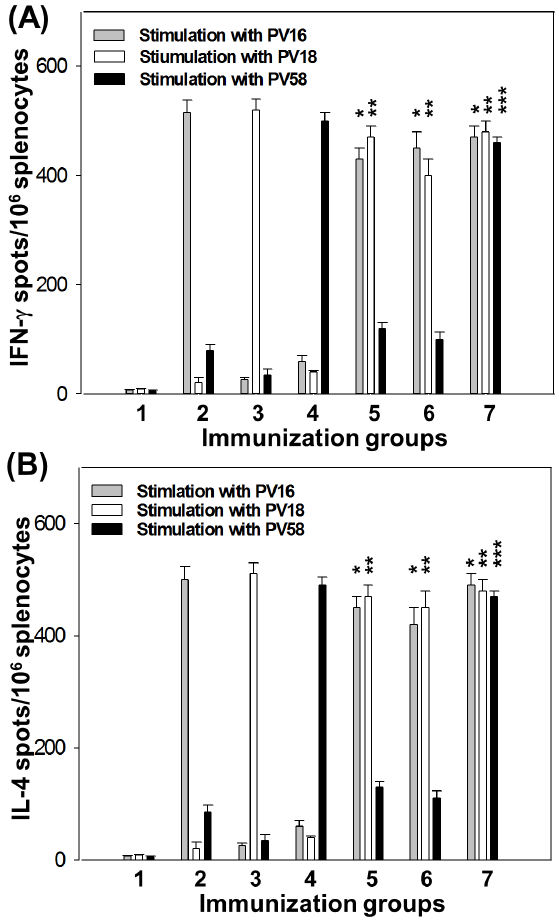
Figure 7. Induction of HPV 16, 18, and 58 L1-specific T cells. Mouse splenocytes were harvested 10 weeks after the first immuniza- tion. (A) The number of IFN- c -producing HPV 16 or HPV 18 or HPV 58- specific CD8 + T cells was determined using an ELISPOT assay. (B) The number of IL-4-producing HPV 16 or HPV 18 or HPV 58-specific CD4 + T cell was determined using an ELISPOT assay. Values represent the number of spots per 10 6 splenocytes following stimulation with HPV 16 or HPV 18 or HPV 58 pseudovirues (PV16, PV18, or PV58). Lane 1: PBS, Lane 2: AcHERV-HP16L1, Lane 3: AcHERV-HP18L1, Lane 4: AcHERV- HP58L1, Lane 5: AcHERV-HP16/18L1, Lane 6: AcHERV-HP18/16L1, Lane 7: AcHERV-HP16/18/58L1. * p , 0.05 (ANOVA and Student-Newman- Keuls test): AcHERV-16L1 group was compared with bivalent or trivalent group. ** p , 0.05 (ANOVA and Student-Newman-Keuls test): AcHERV- 18L1 group was compared with bivalent or trivalent group. *** p , 0.01 (ANOVA and Student-Newman-Keuls test): AcHERV-58L1 group was compared with trivalent